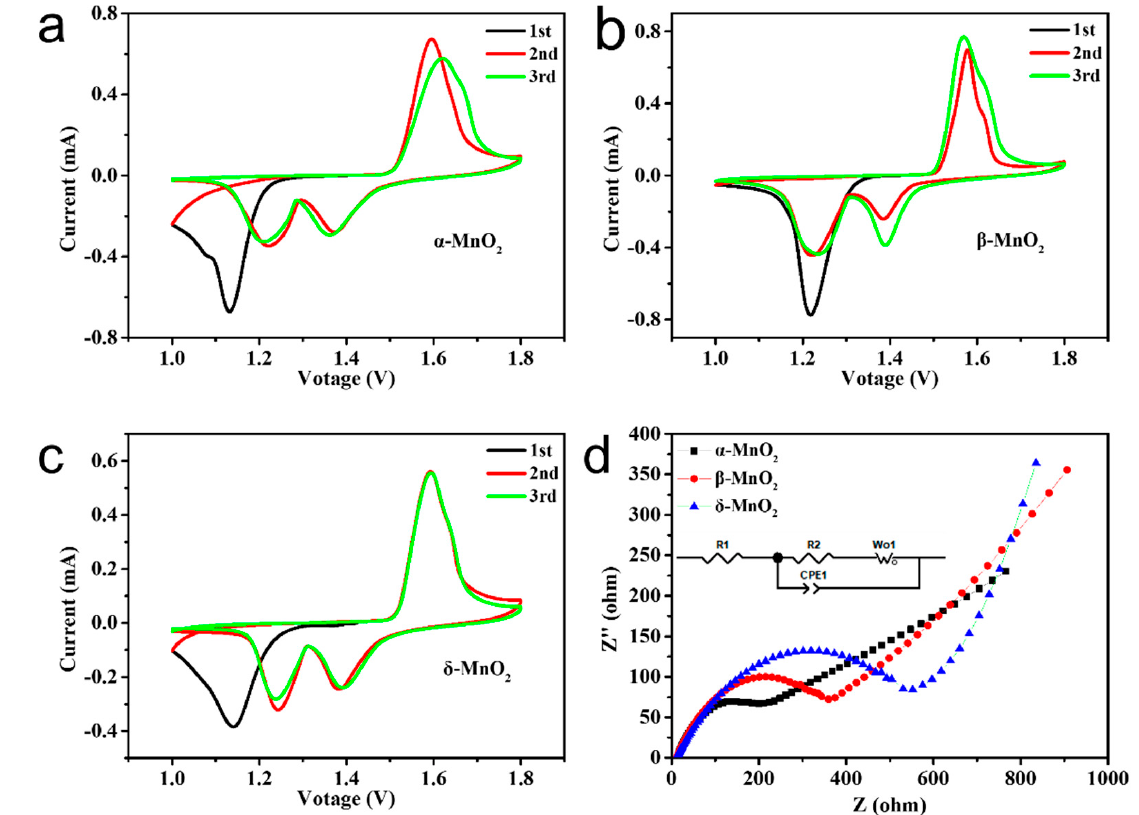
Figure 5. The different cyclic voltammogram (CV) profiles of ( a ) α -MnO 2 , ( b ) β -MnO 2 , and ( c ) δ - MnO 2 at a scan rate of 0.1 mV s − 1 from 1.0 to 1.8 V; ( d ) the electrochemical impedance spectroscopy (EIS) of α -MnO 2 , β -MnO 2 , and δ -MnO 2 electrodes.